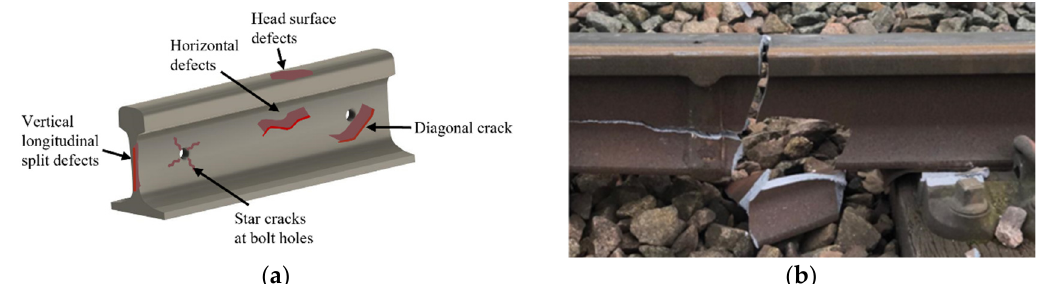
Figure 1. ( a ) Schematic and ( b ) in situ illustration of rail track damages.